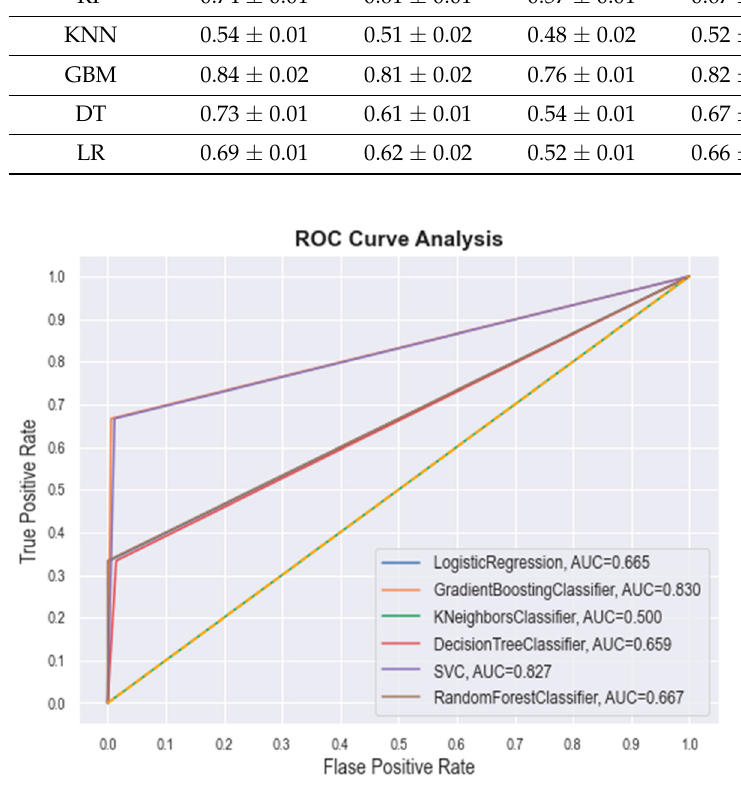
Figure 4. ROC curves for different ML